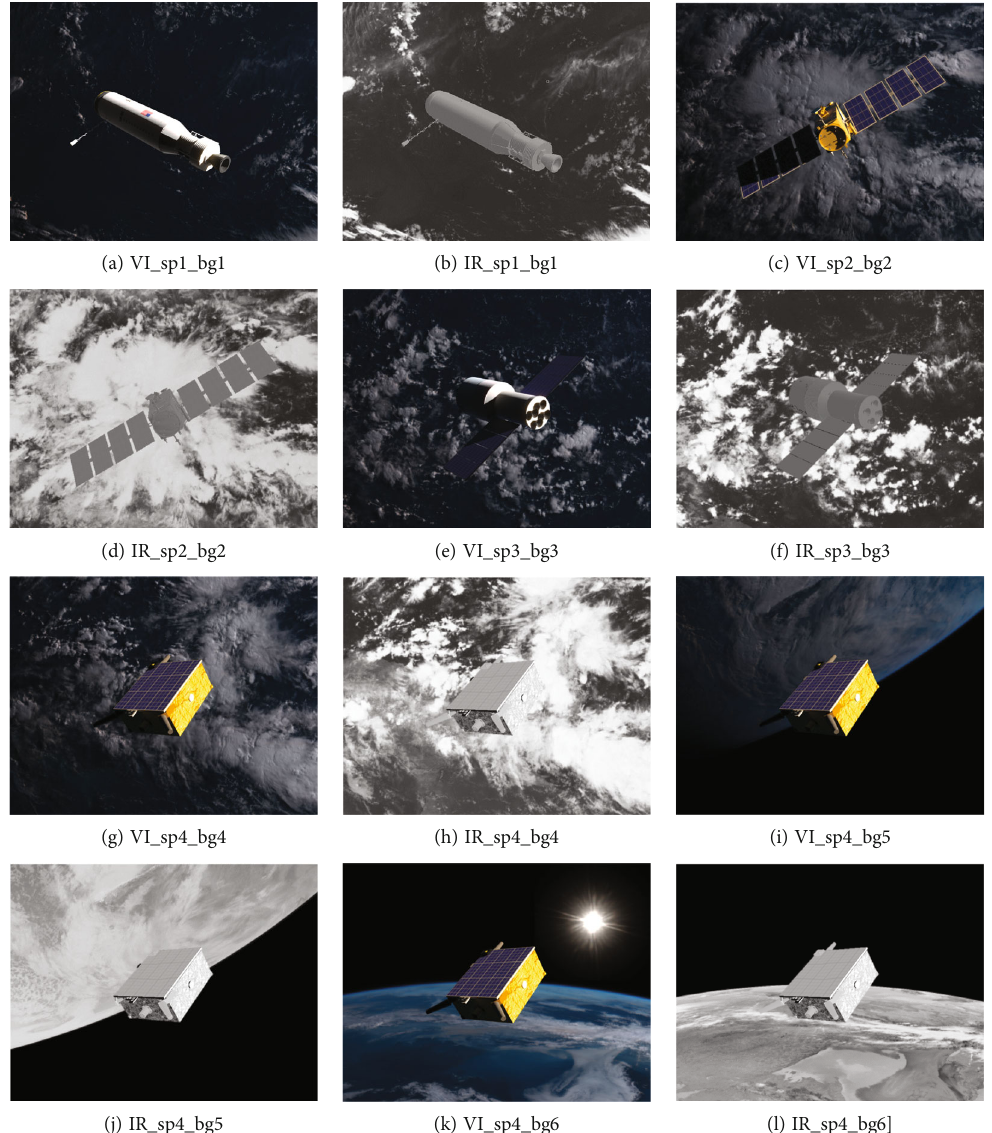
Figure 3: Examples of the SDD dataset. “ VI ” means the visible image, “ IR ” means the infrared image, “ sp i ” { i = 1,2,3,4 } means the i th space debris of SDD, and “ bg i ” { i = 1, 2, ⋯ , 6 } means the i th type of the background of